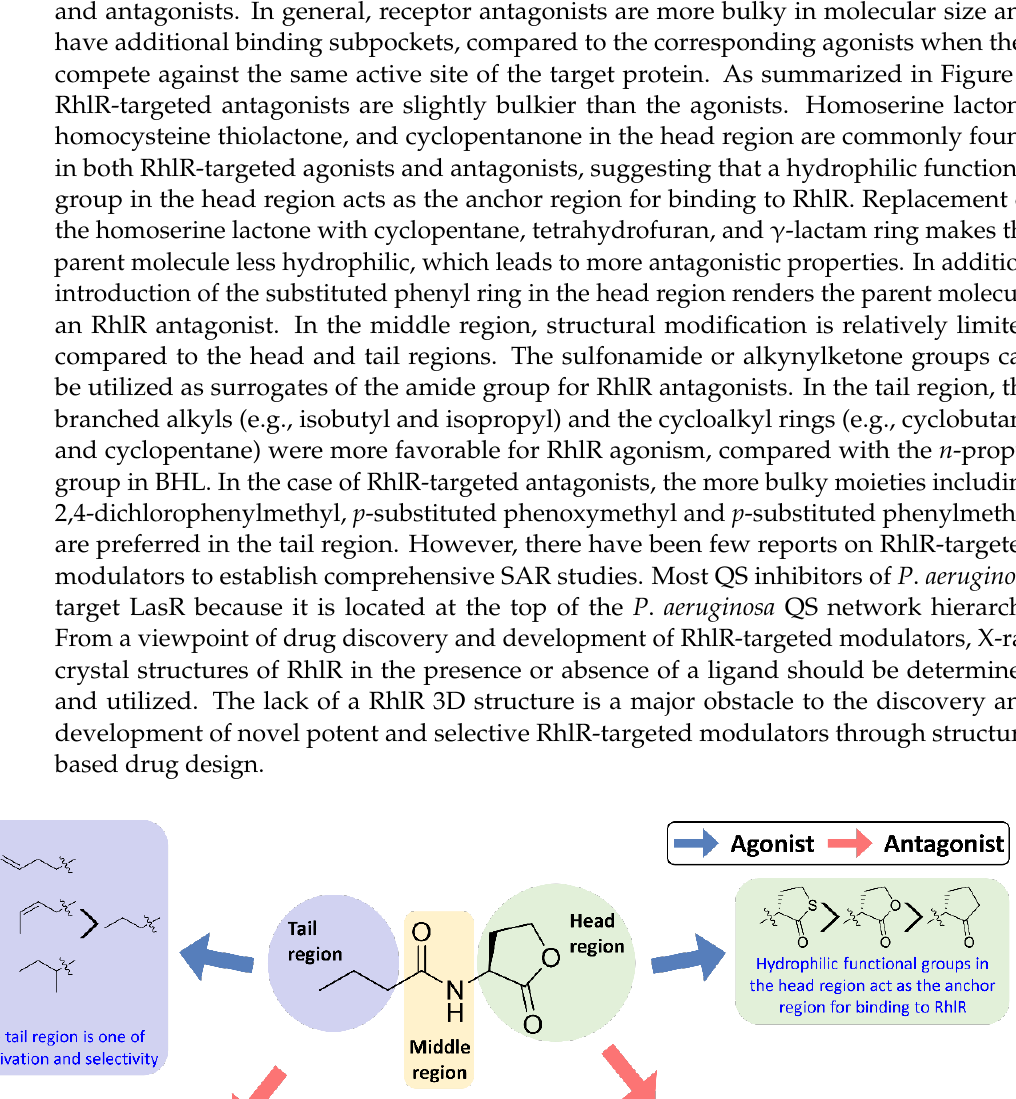
QS. RhlR produces QS-regulated virulence factors in E90 isolates, and it was the critical determinant of cytotoxicity in a 3-D lung epithelium cell model [28]. In general, the